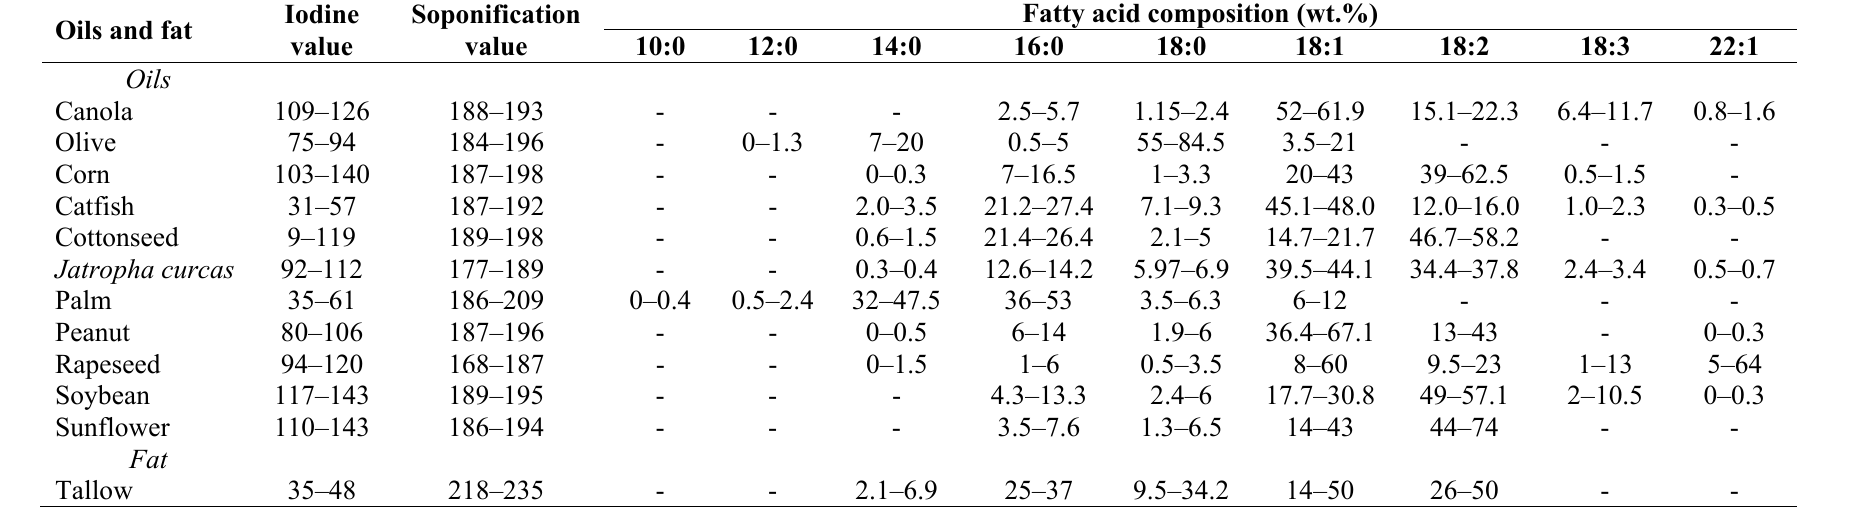
Table 2. Major fatty acids in oils and fat [6–9].